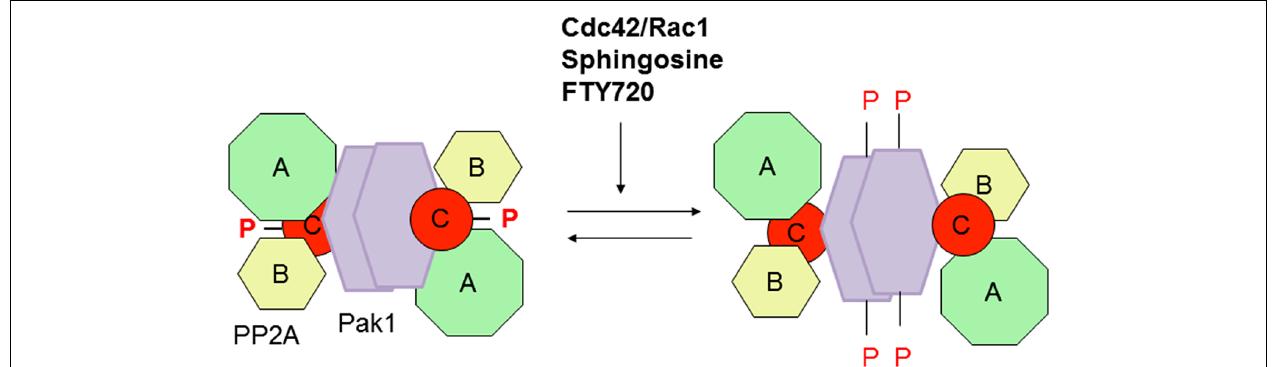
FIGURE 3 | Activation of phosphatase PP2A by Pak1 scaffolding. Through a conformational change associated with Pak1 autophosphorylation, PP2A undergoes auto-dephosphorylation with increased phosphatase activities. Pak1 remains in dimer form and associated with PP2A even after